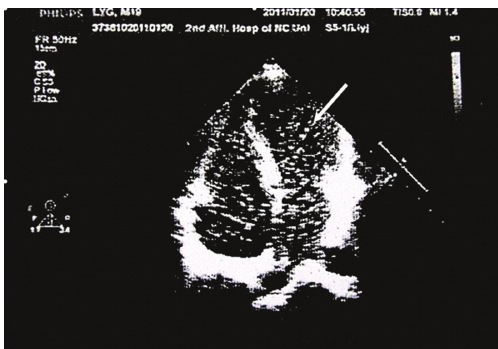
Figure 1: Finger clubbing.